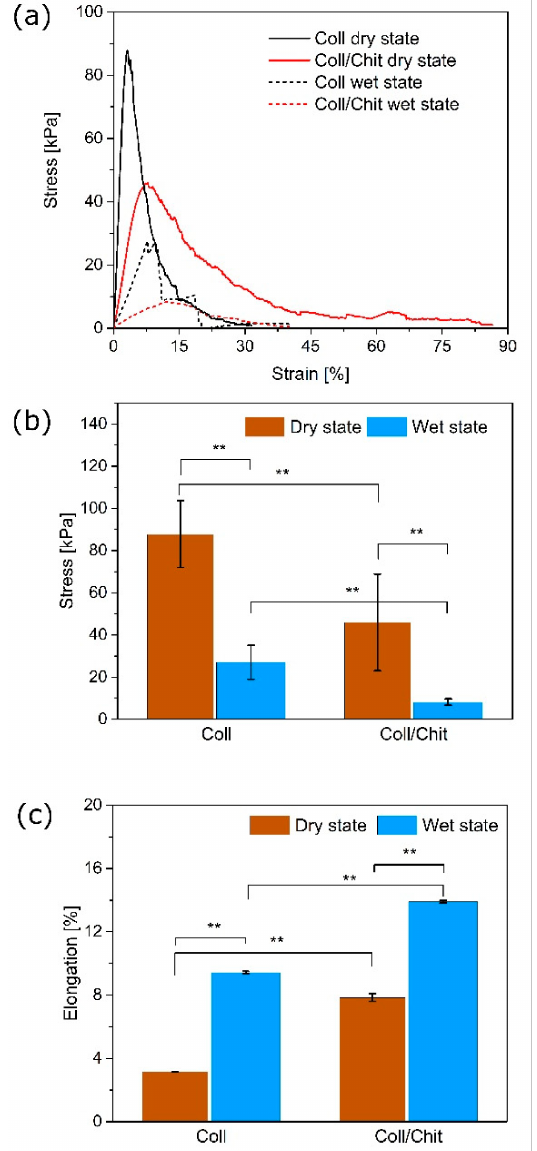
Figure 3. ( a ) Tensile curves of Coll and Coll/Chit scaffolds at dry and wet state; ( b ) the overview of stress values applied on Coll and Coll/Chit scaffolds at dry and wet state; ( c ) percentage elongation influenced by chitosan addition to collagen scaffold at dry and wet state; ** p <